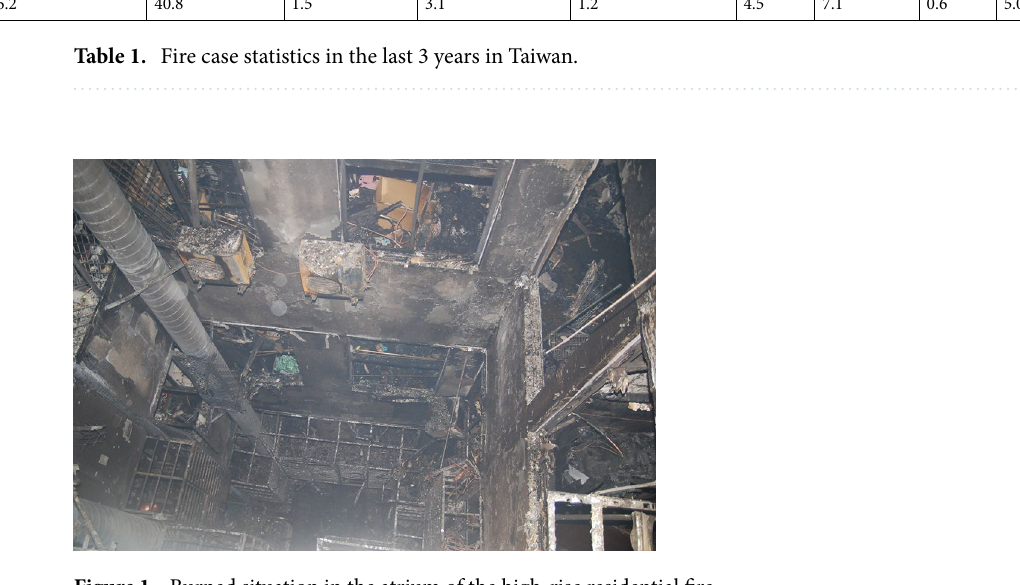
Figure 1. Burned situation in the atrium of the high-rise residential fire.